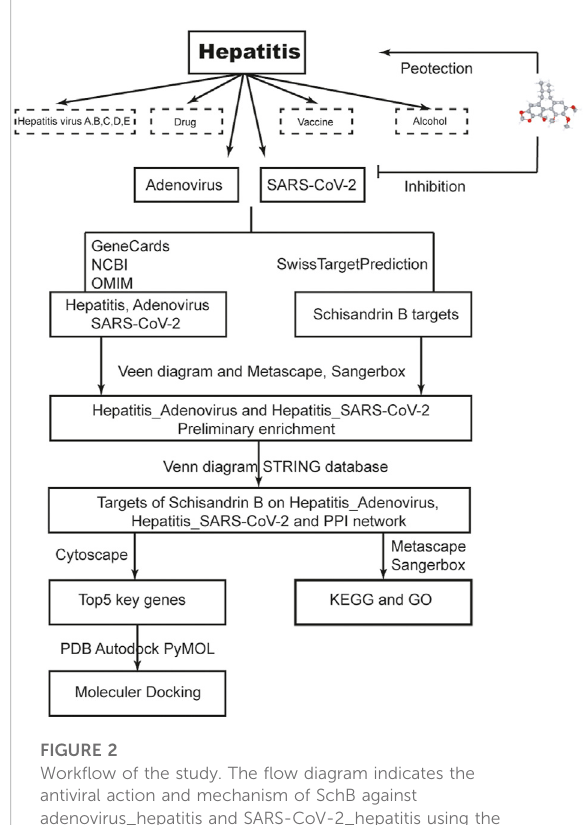
FIGURE 2 Work fl ow of the study. The fl ow diagram indicates the antiviral action and mechanism of SchB against adenovirus_hepatitis and SARS-CoV-2_hepatitis using the network pharmacology analysis approach.